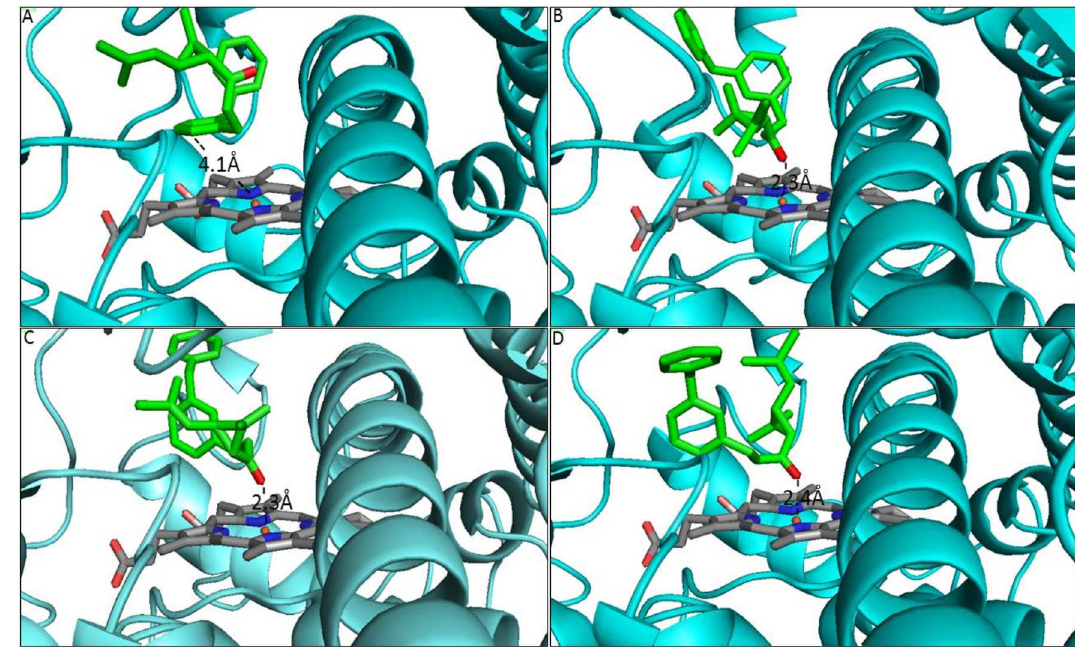
Fig 3. Binding conformation of permethrin in (A) KL, (B) JB, (C) PG and (D) NO CYP9J27 models. Distances betweenthe probablesites of attack on permethrin and the heme iron are